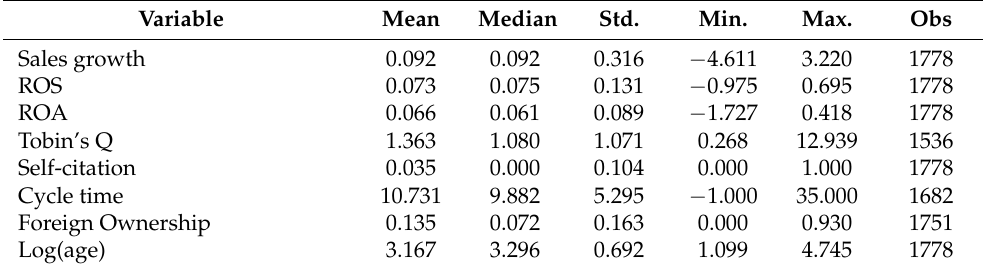
Table A3. Descriptive statistics of variables in regressions with innovation